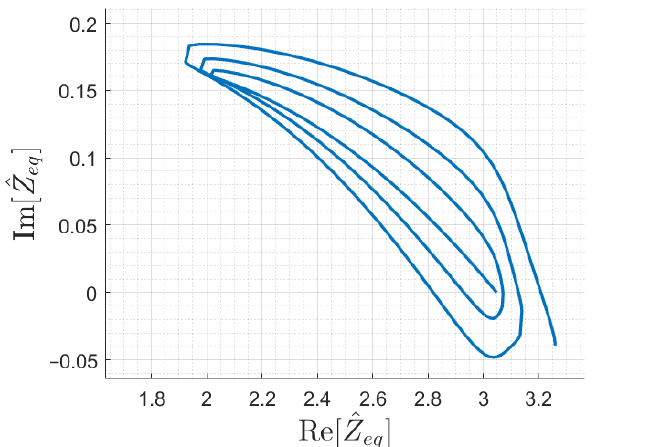
Figure 10. Input impedance trajectory as a function of the receiver position for the resonator array with a series-compensated receiver and short-circuit termination.